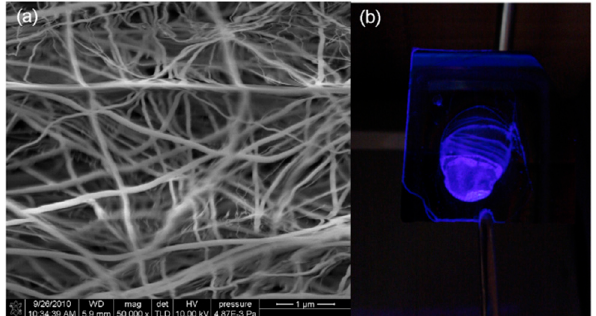
Figure 27. ( a ) SEM image of the silica nanowires functionalized with cryptophane-A; ( b ) luminescent emission of the nanowires when illuminated with UV radiation. Reprinted from [142] with permission from Elsevier.